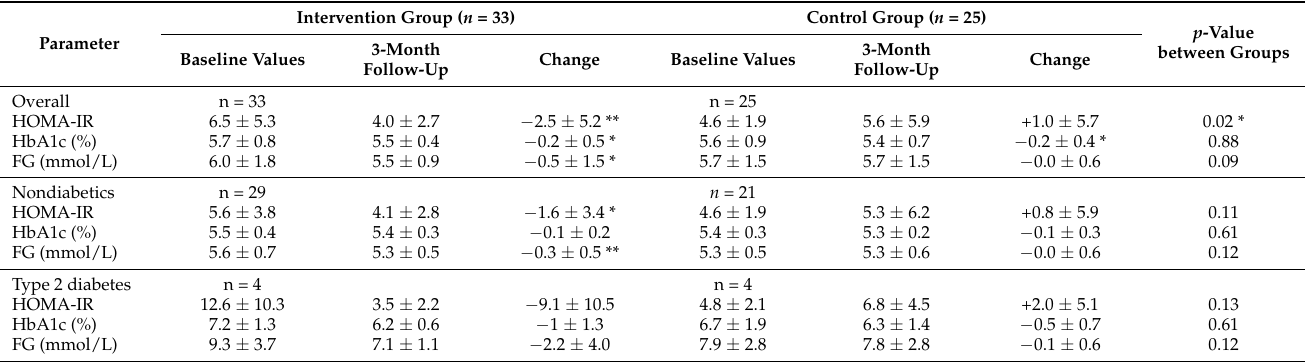
Table 5. Change in parameters of glucose metabolism in 3-month complete cases.